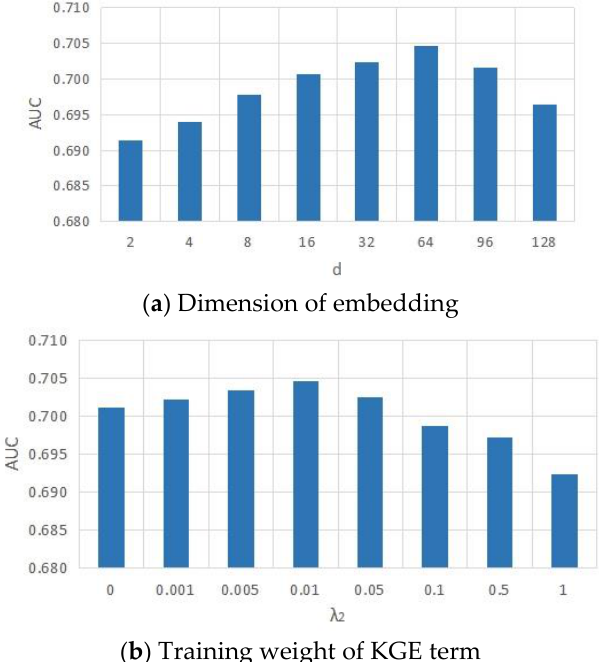
Figure 4. Parameter sensitivities of NRTEH.